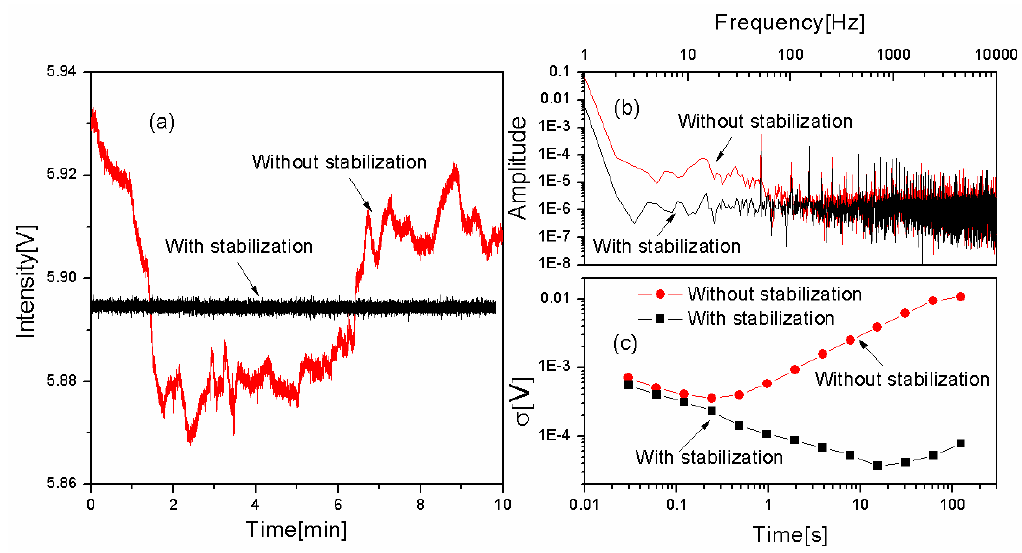
Figure 3. ( a ) Long term monitoring of the light intensity with and without stabilization; the ( b ) corresponding noise spectra and ( c ) Allan-Werle deviations.